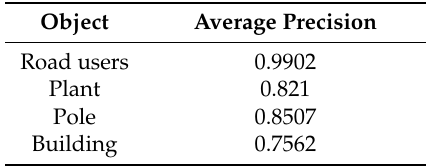
Table 6. The average classification precision of each